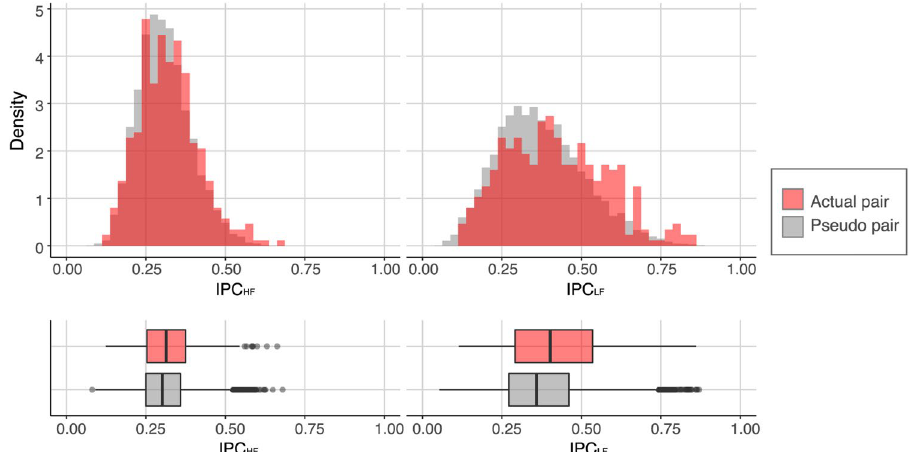
Figure 3. Density plots and box plots for interpersonal physiological coherences (IPCs) in the high-frequency band (IPC HF ) and low-frequency band (IPC LF ) as a function of pair type. The red bars represent IPCs of actual pairs. The grey bars represent the IPCs of pseudo pairs. The pseudo pairs included all of the possible combinations of two participants who took part in different